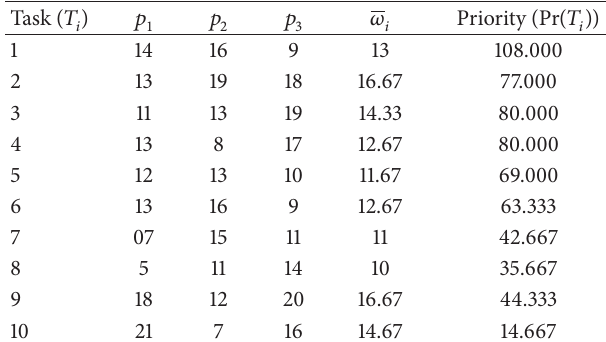
Table 2: Task execution times and priorities.